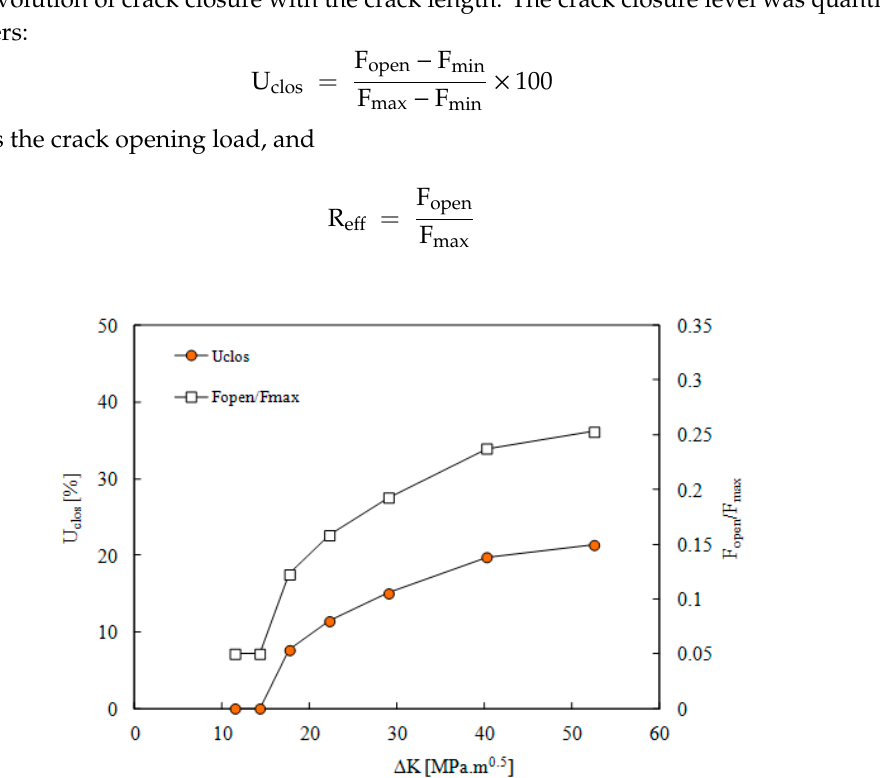
Figure 8. Crack closure level versus Δ K (18Ni300; R = 0.05).